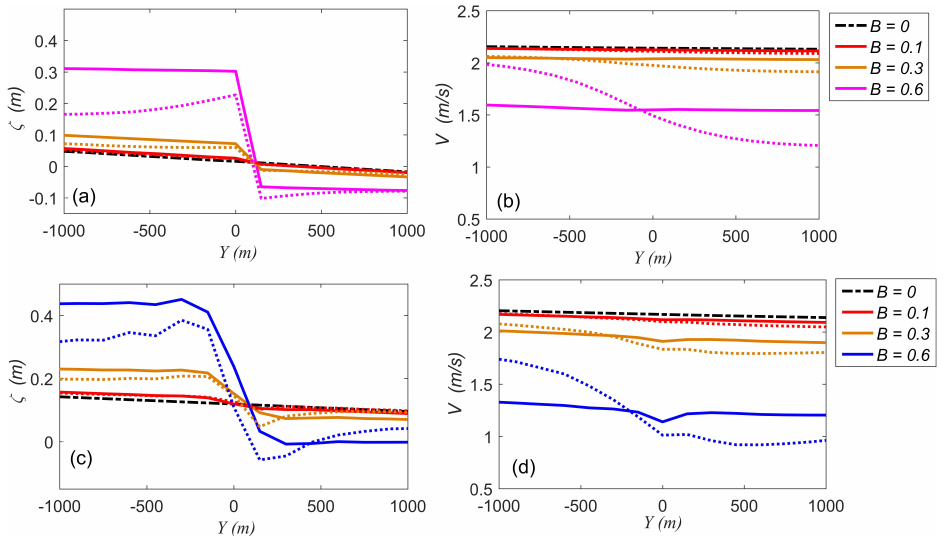
Figure 8. Stream-wise profile of the water elevation ζ and Y component of the velocity, along the channel centreline, for a fence (continuous line) and partial-fence (dashed line) configuration obtained with ADI ( a , b ) and TVD ( c , d